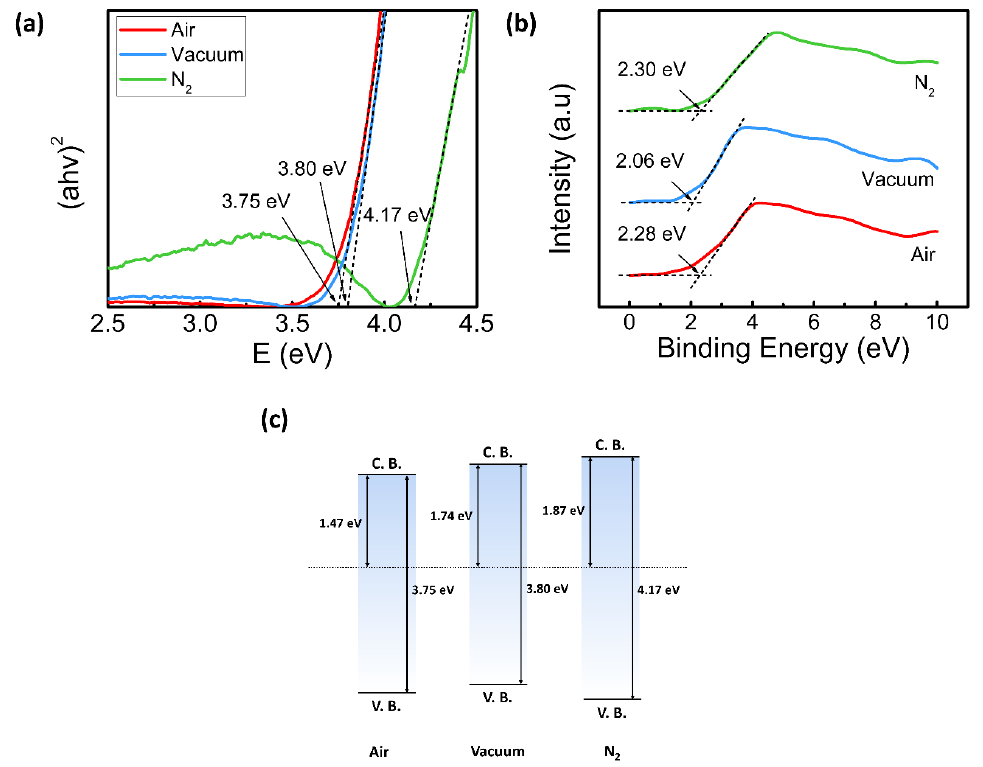
Figure 4. ( a ) Dependence of (αhv) 2 on the photon energy (hv) of SnO 2 films annealed in air, vacuum, and N 2 . ( b ) XPS spectra collected from regions near the valence band. ( c ) Energy level diagram including the relative energy position of the Fermi level (EF) with respect to the conduction band minimum and valence band maximum.